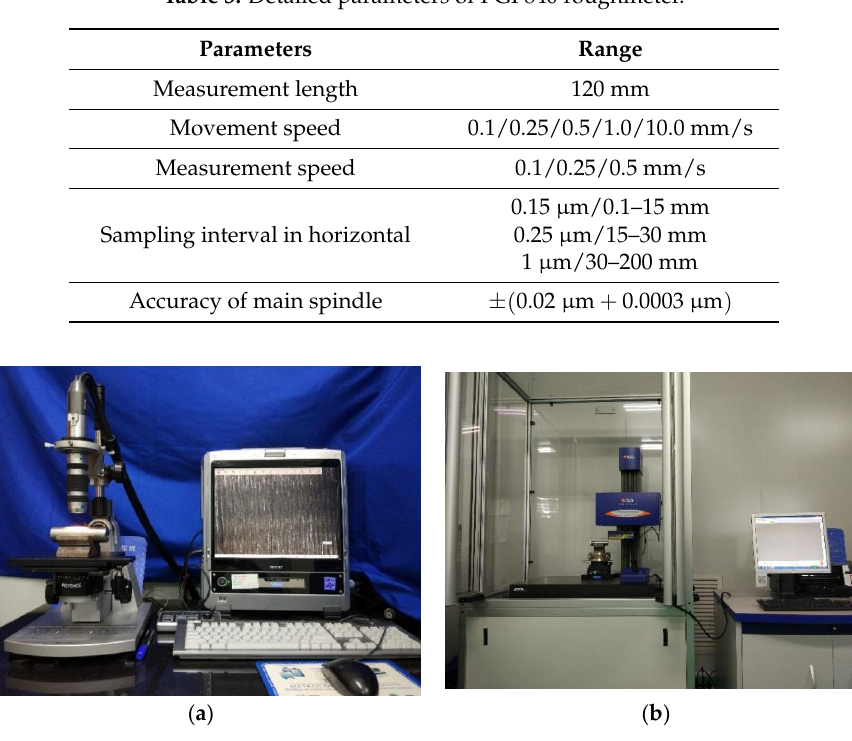
Figure 2. Measurement equipment: ( a ) VHX-600E digital microscope; ( b ) PGI 840